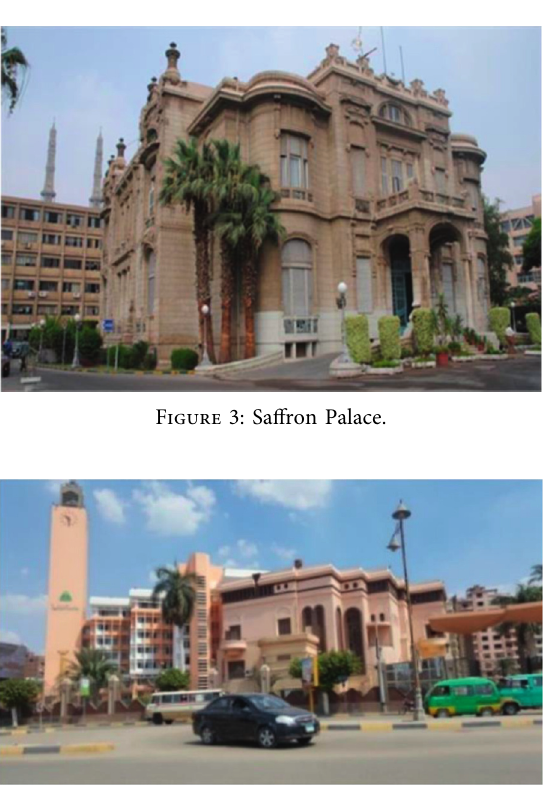
Figure 4: Al-Jazzar Palace.